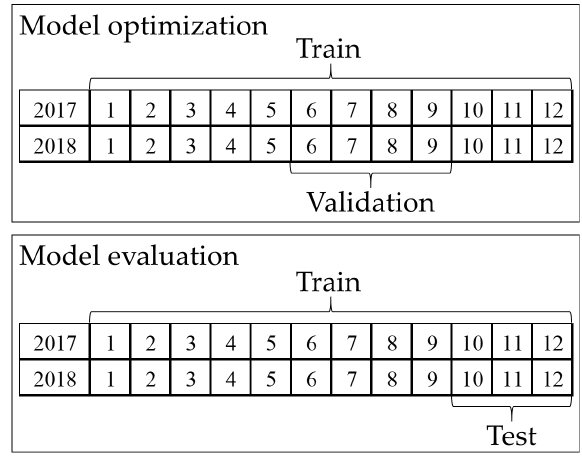
Figure 5. Model validation and evaluation.